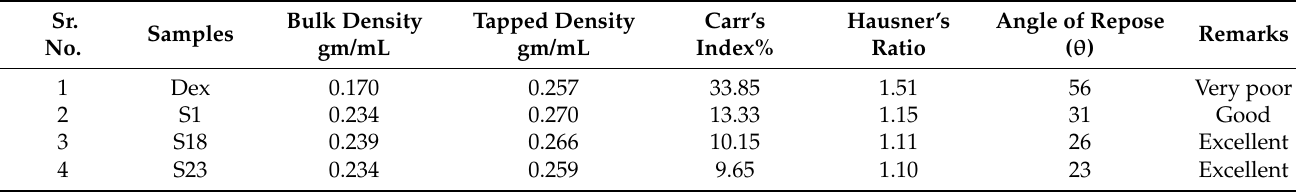
Table 6. Flow properties of optimized formulation powders.